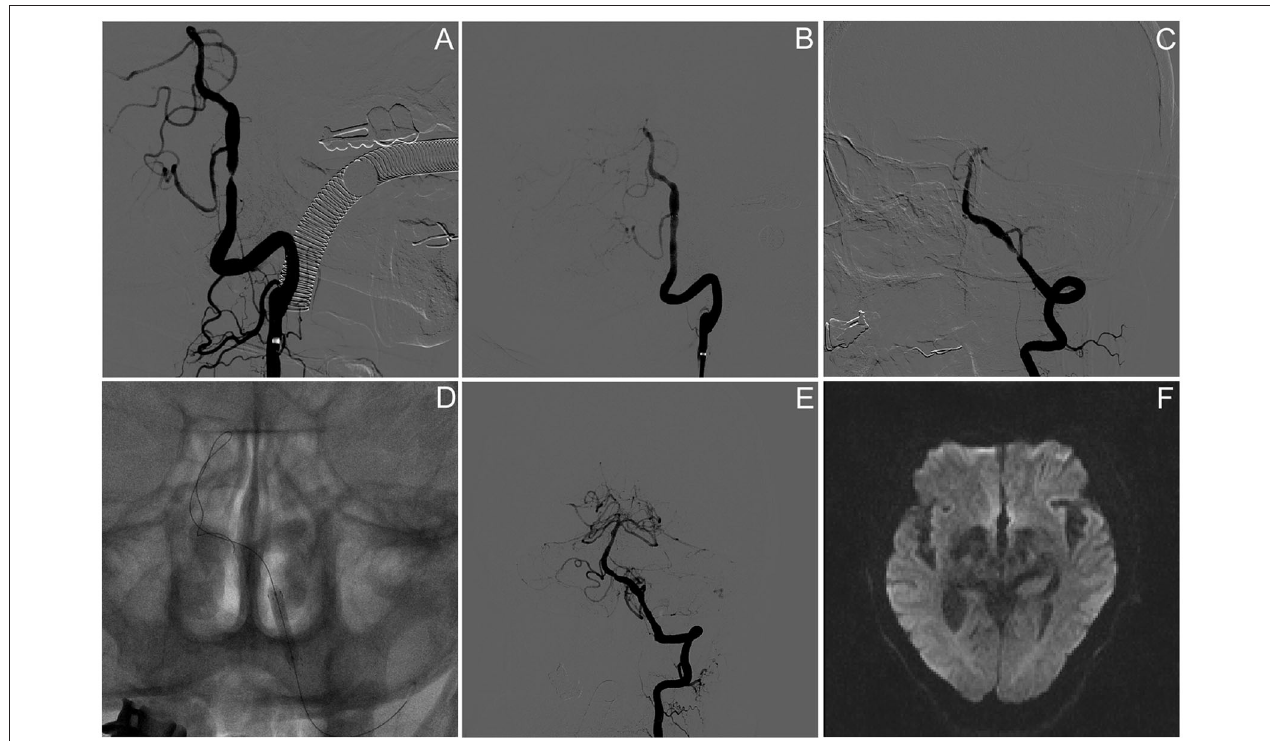
FIGURE 1 | Paclitaxel-coated balloon angioplasty for intracranial sISR. (A) Symptomatic severe vertebral artery atherosclerotic stenosis despite of aggressive medical management. (B) Angiography results after PTAS using wingspan stent. (C) Symptomatic ISR because of the discontinuance of aggressive medical management. (D) Drug-coated balloon dilatation. (E) Angiographic result after the DCB angioplasty. (F) Brain DWI result on day 5 after procedure presented no new